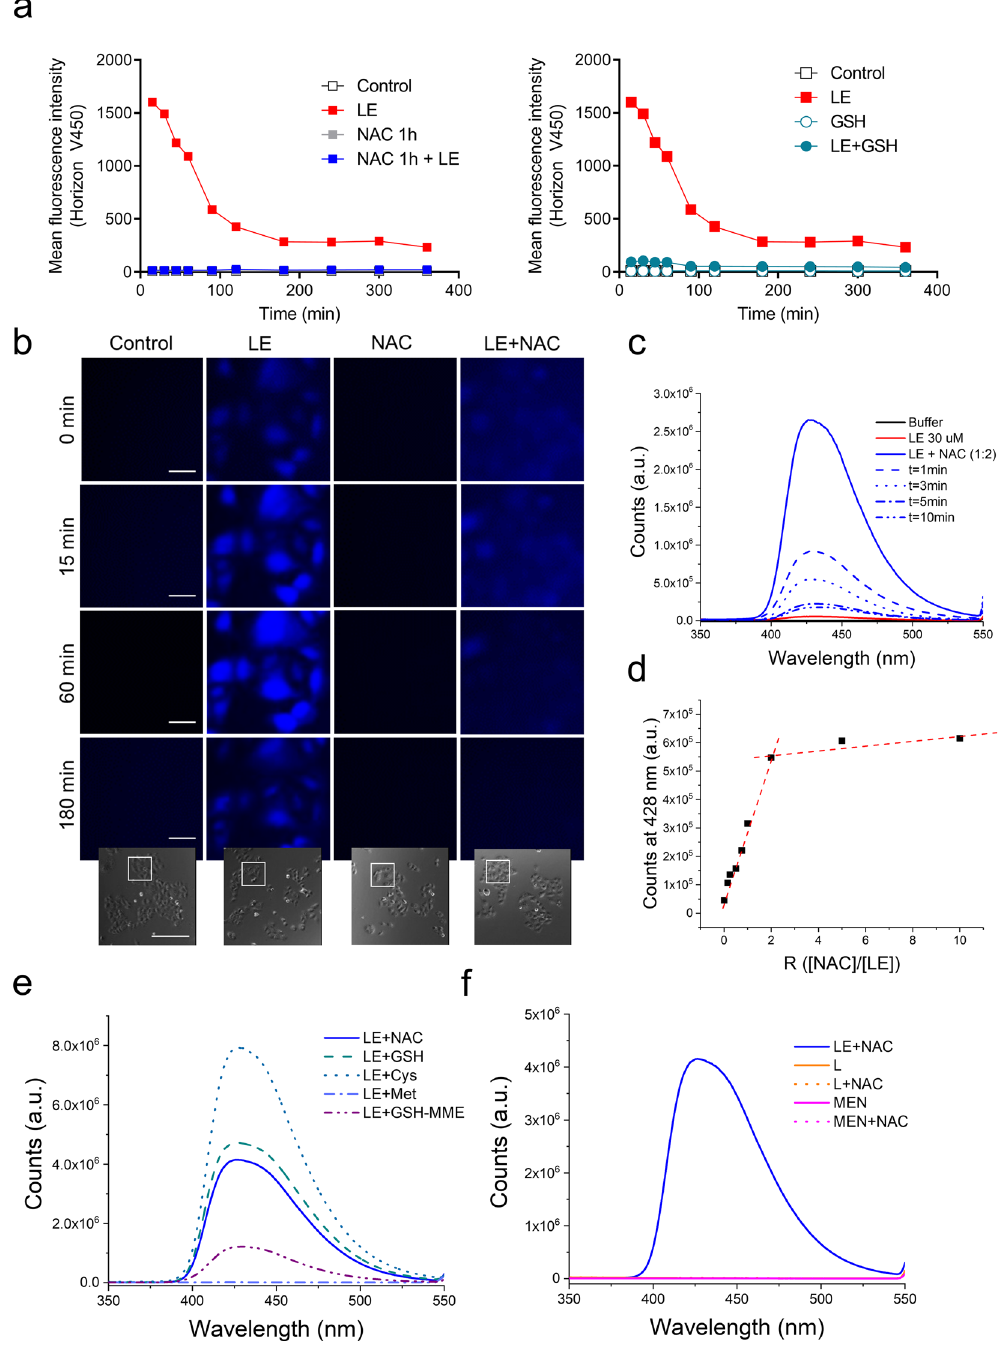
Fig. 5 Landomycin E fl uorescent properties upon Michael adduct formation. a Intracellular fl uorescence of LE exposed Jurkat cells was detected by fl ow cytometry. Cells were treated with 4 µ M LE-alone or after preincubation with the cysteinyl thiols NAC (1 mM, left panel) or GSH (1 mM, right panel). Intracellular fl uorescence was quanti fi ed at indicated time points by fl ow cytometry (Horizon V450 (emission 448 nm)). b LE-induced intracellular fl uorescence of MG63 osteosarcoma cells was followed over time by live-cell imaging (DAPI channel) after treatment with 4 µ M LE with or without 1 mM NAC pre/coincubation (1 h). Scale bar indicates 10 µ m ( fl uorescence images) and 100 µ m (phase-contrast insets). The small phase-contrast images at the bottom, taken at the start of the experiment (time point 0), indicate the cell groups shown enlarged in the respective upper fl uorescence panels. c Fluorescence pro fi le of LE alone (red solid line) and in combination with NAC ( λ exc = 280 nm). Spectra of the same solution have been recorded immediately after mixing LE with NAC (blue solid line) and after the time points indicated in the legend (blue dashed and dotted lines). Slits width: 5 nm/ 5 nm. d Plot of LE emission in combination with NAC ( λ exc = 280 nm, λ em = 428nm) at different concentrations. e Fluorescence pro fi le of 40 μ M LE in combination with 200 μ M NAC (blue solid line), GSH (green dashed line), Cys (sea green dotted line), GSH – MME (violet dash – dot – dot line), and Met (light blue dash – dot line). Slit width: 2 nm/5 nm. f Fluorescence pro fi le of 15 μ M L (orange solid line) and 30 μ M menadione (MEN, fuchsia solid line) in combination with 60 μ M NAC (corresponding dotted lines). For comparison, the fl uorescence pro fi le of 40 μ M LE in combination with 200 μ M NAC is depicted as blue solid line. λ exc = 280 nm; slit width: 5 nm/5 nm; Buffer: Tris-HCl 50 mM, pH = 7.4 for b , c , d , and e .